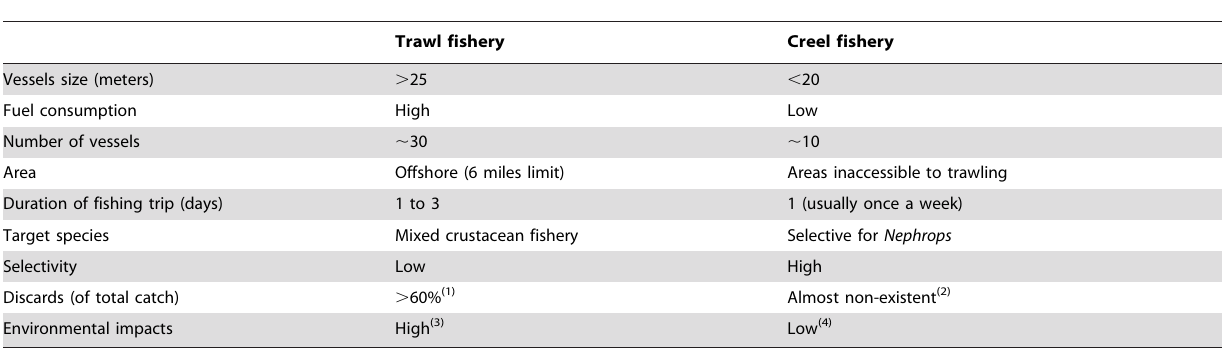
Table 1. Main differences between trawl and creel Nephrops